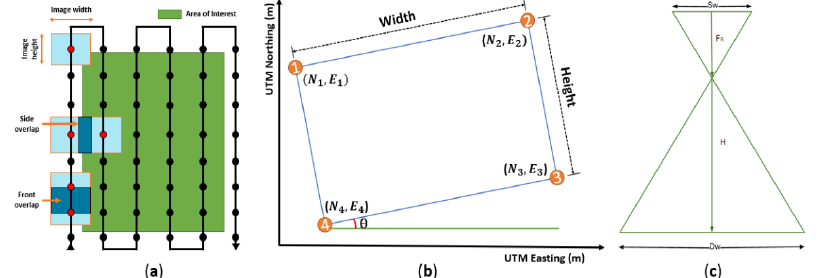
Figure 3. Variables to consider when generating a path: ( a ) an example of the overall path; ( b ) vertex of the area to be captured; ( c ) correlation of camera capture.